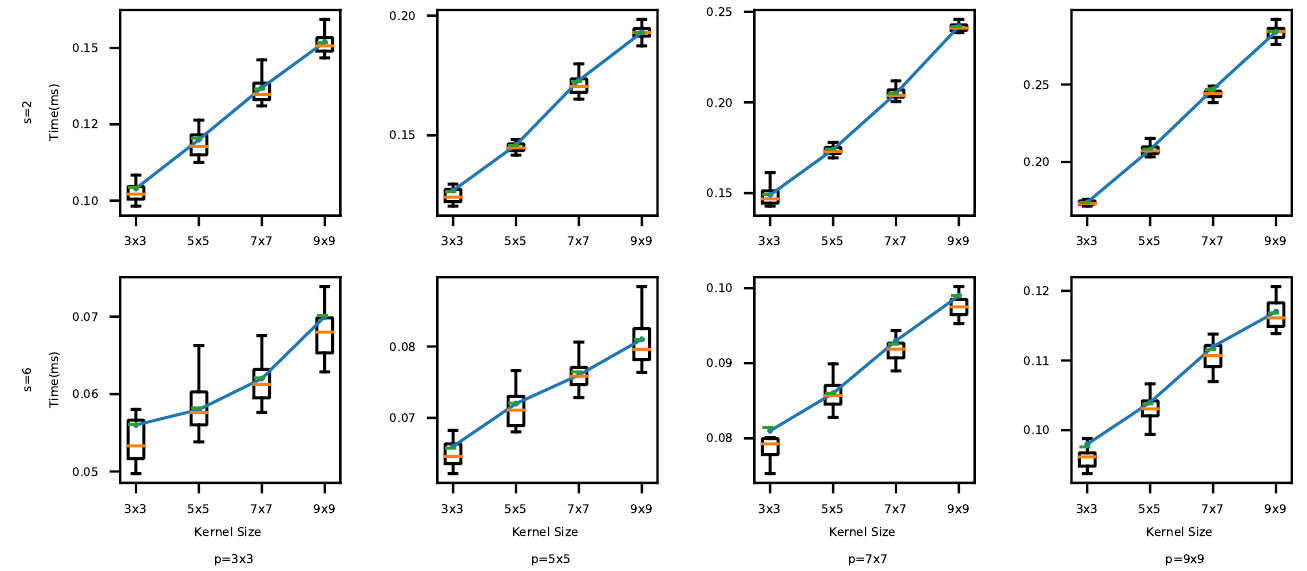
Figure 7. Kernel Size vs. Execution Time (CIFAR-10). The execution time increases for the increasing kernel size across different s and p values. These results are expected, since a bigger kernel usually requires more computation. However, the accuracy does not necessarily increase as the kernel size increases as shown in Figure 8.